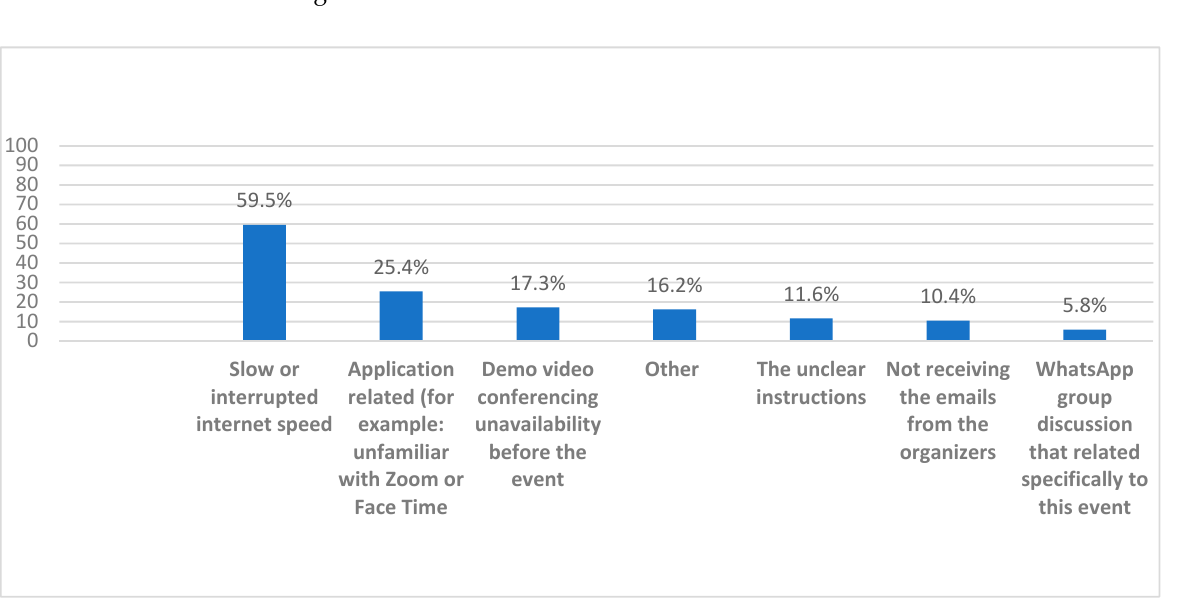
Figure 9. The faculty members’ perceived factors that negatively affected the medical residents’ E-interviews experience.